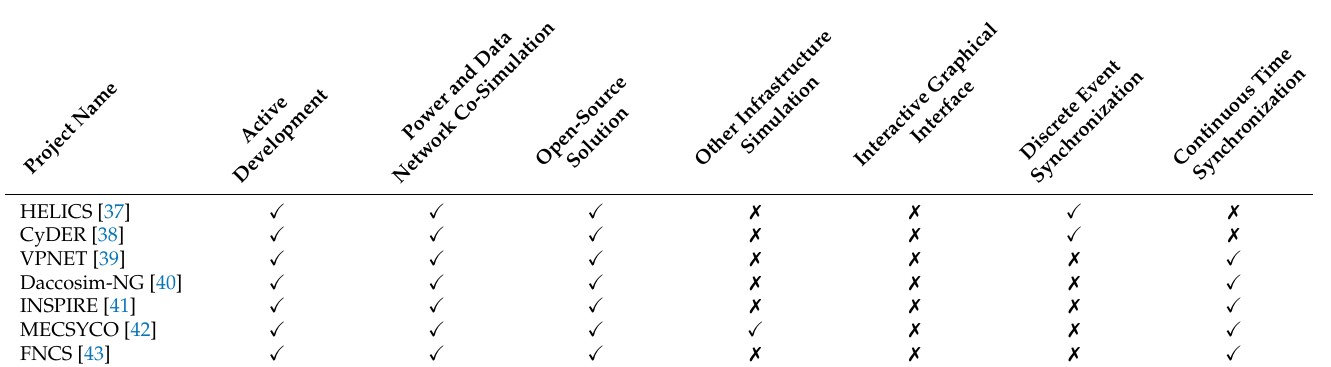
Table 3. Comparison of Available Smart Grid